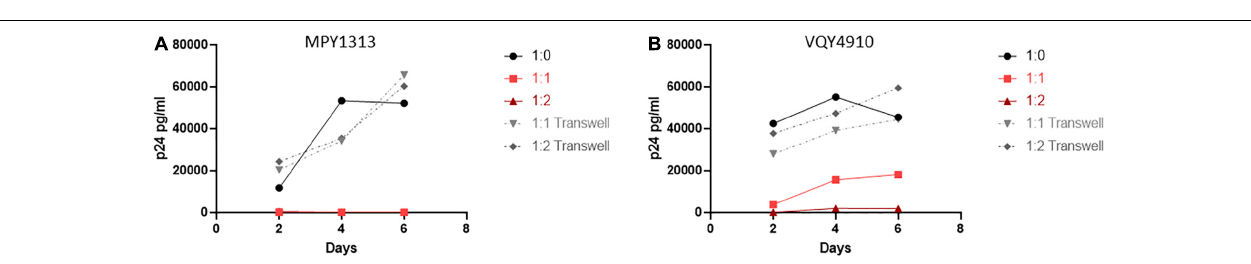
FIGURE 7 | Cell contact is necessary to mediate viral suppression in LVLs. CD4 + T-cells were isolated from post-therapy samples from (A) MPY1313 and (B) VQY4910 and cultured with isolated CD8 + T-cells from the same donor pre-therapy. CD4 + and CD8 + T-cells were stimulated with PHA and IL-2 for 48 h before being combined in the given ratios (CD4:CD8) in direct contact (red solid lines) or in transwell (gray dashed lines). Cultures were infected with NL4-3, supernatant was collected every 48 h post infection and virus levels were determined by p24